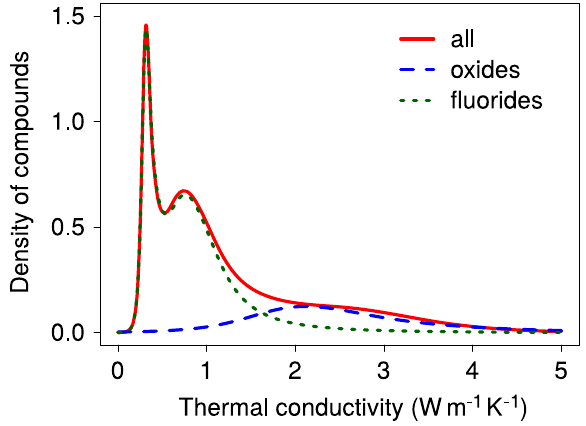
FIG. 6. Distribution of compounds as a function of the lattice thermal conductivity at 1000 K. The red curve corresponds to the distribution for all mechanically stable compounds. The blue curve corresponds to the distribution for oxides only. The green curve corresponds to the distribution for fluorides